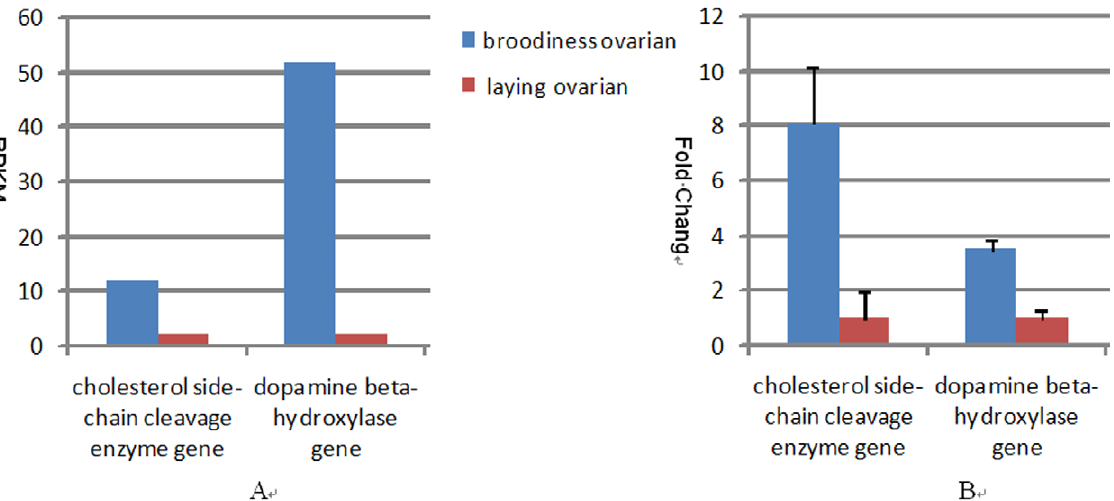
Figure 7. Analyses of the differentially expressed genes during the goose laying stage. (A) The gene expression levels of cholesterol side- chain cleavage enzyme gene and dopamine beta-hydroxylase gene were determined by calculating the number of unambiguous reads for each gene and then normalizing to RPKM (Reads per kilobase transcriptome per million mapped reads). (B) Gene expression data obtained by qRT-PCR analysis. Expression ratios of the two genes in ovarian samples from laying and broodiness